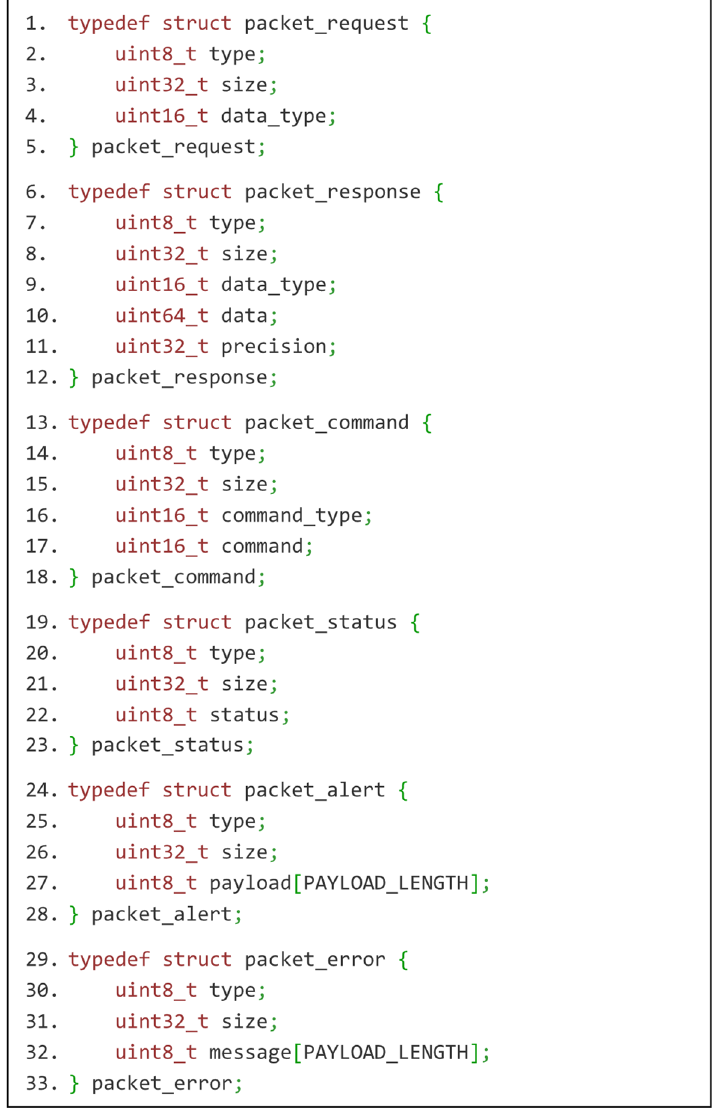
Figure 7. IoT-Transmission-Protocol messages presented as C structures (sensor reading request, sensor reading response, actuator command, command execution status, alert message and error message).